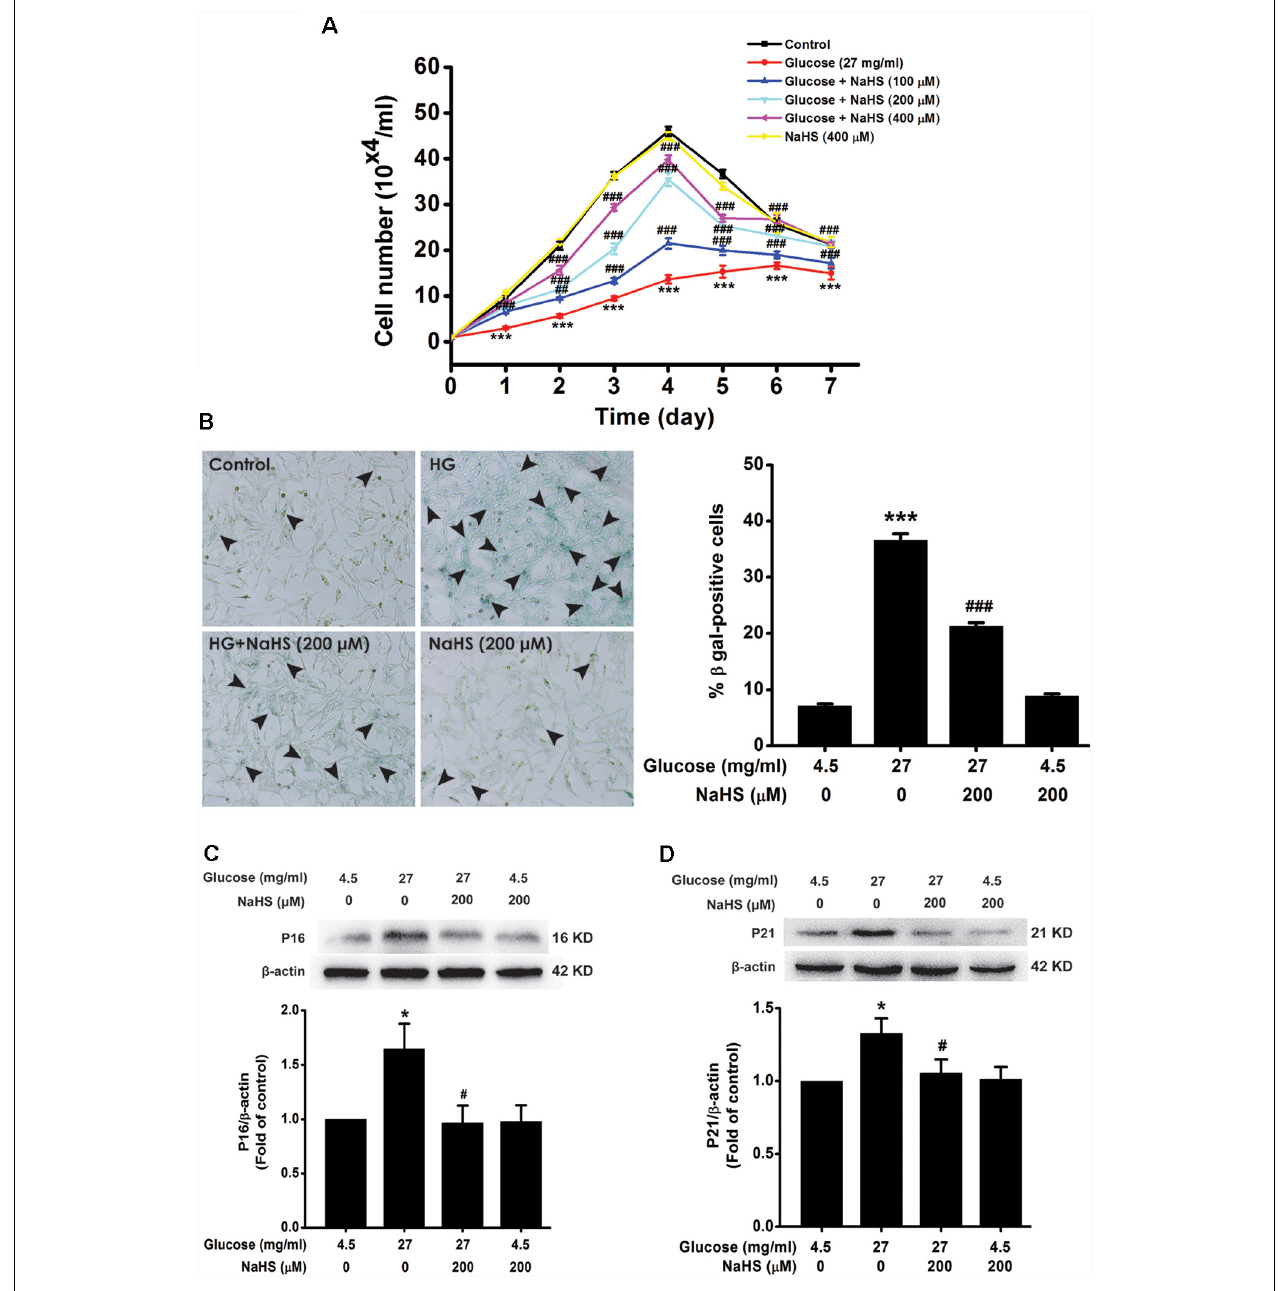
FIGURE 1 | Effect of hydrogen sulfide (H 2 S) on high glucose (HG)-elicited cellular senescence in HT22 cells. (A) Cell growth curves were generated using Trypan blue stain assays. (B) Representative images of senescent cells that were stained using senescence associated- β -galactosidase (SA- β -gal; Left, Magnification × 100) and quantitative analysis of the SA- β -gal positive cells (Right). The black arrows indicate the senescent cells, (C,D) The expressions of p16 INK4a and p21 CIP1 in HT22 cells were detected by Western blotting. Values were expressed as the mean ± SEM, n = 3. ∗ P < 0.05, ∗∗∗ P < 0.001, vs. control group; # P < 0.05, ## P < 0.01, ### P < 0.001 vs. HG-treated alone group.